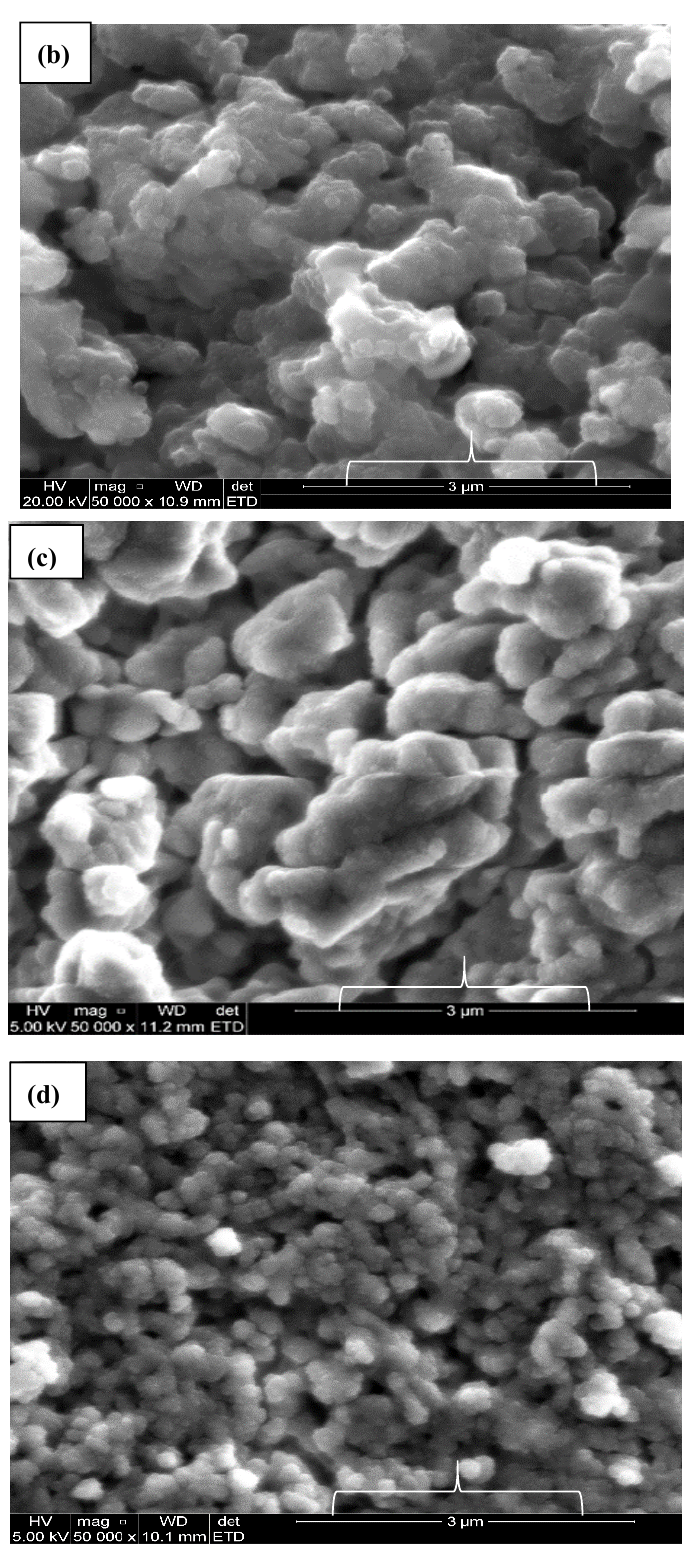
Figure 4. SEM images of ( a ) cCuO, ( b ) wCuO, ( c ) aCuO and ( d ) eCuO.